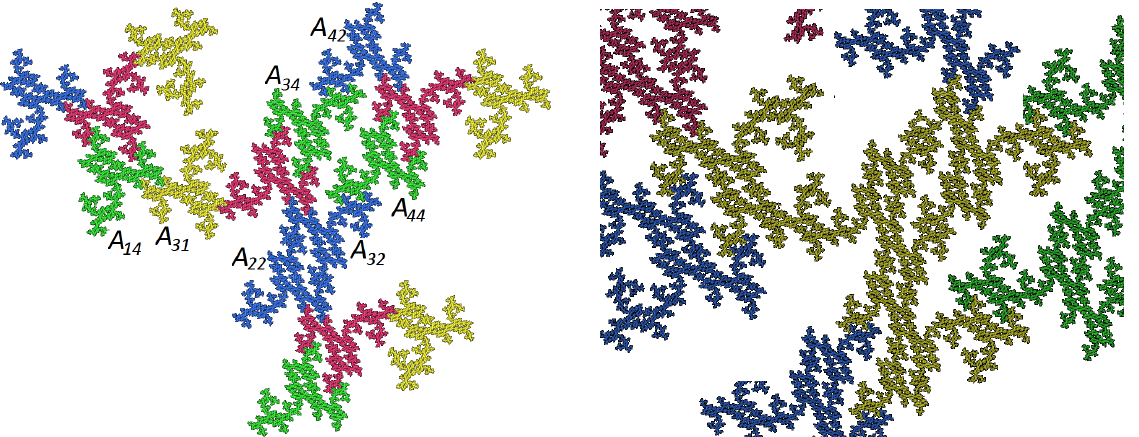
Figure 5. ( Left ): second level pieces Figure 3, colored with respect to the second index. ( Right ): the five possible neighbors of A determine the boundary